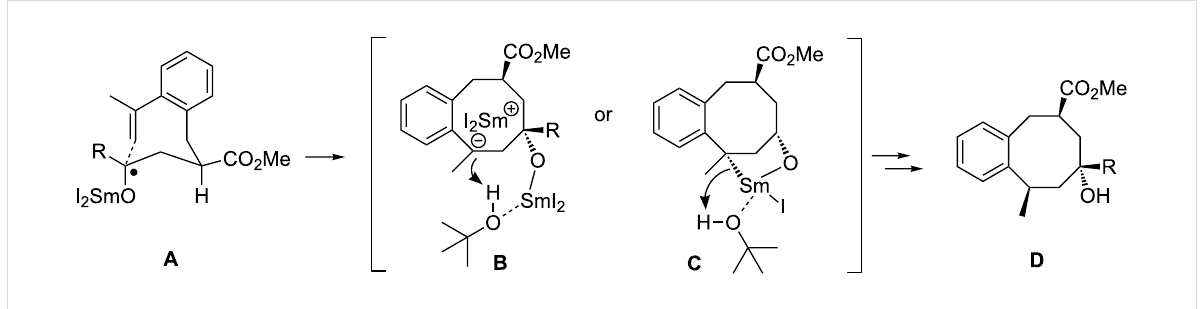
In cyclizations of the (2-propenyl)phenyl-substituted ketoesters, trans -products are preferred; however the cis / trans stereoselec- tivity was generally lower than that observed for the cyclizations of their styrene analogues [33]. It seems that the previously observed correlation between the bulkiness of a ketone subunit and the increase in stereoselectivity is also effec- tive here. This result is in accordance to the proposed eight- membered pseudo-chair-like transition structure [33], where the methoxycarbonyl group occupies a preferred pseudo-equatorial position and the ketyl substituent is competing with the bulky samariumoxy group for the other pseudo-equatorial position.